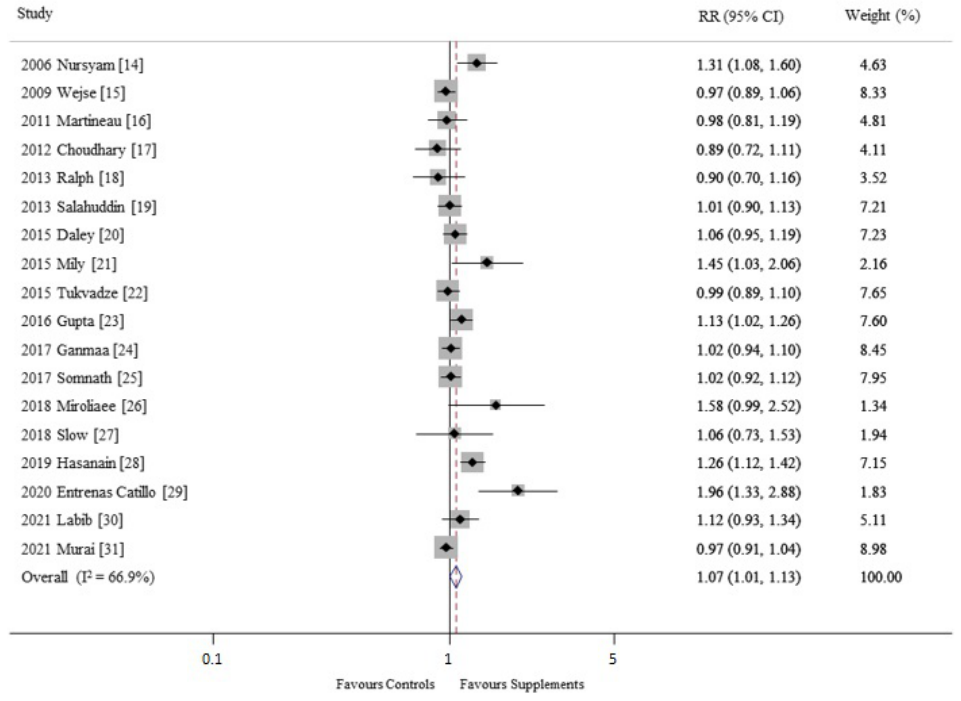
Figure 2. Efficacy of vitamin D supplements in treatment of acute respiratory infections in a meta- analysis of randomized controlled trials ( n = 18) [14–31]. RR, relative risk; CI, confidence